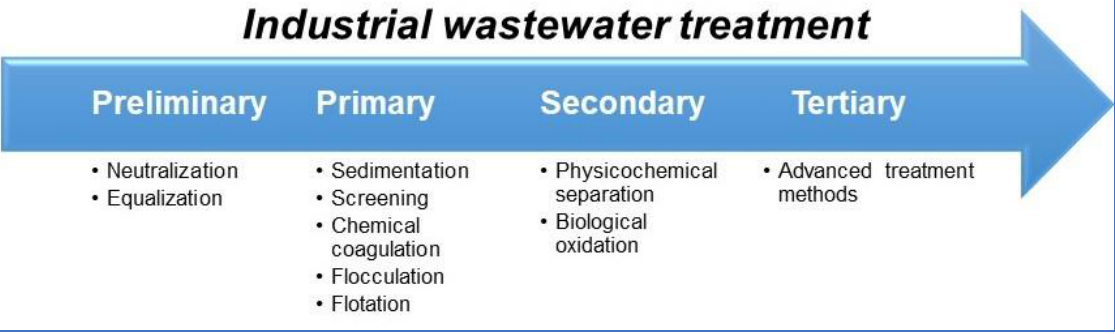
Figure 4. Hierarchy of stages involved in a typical industrial wastewater treatment plant.